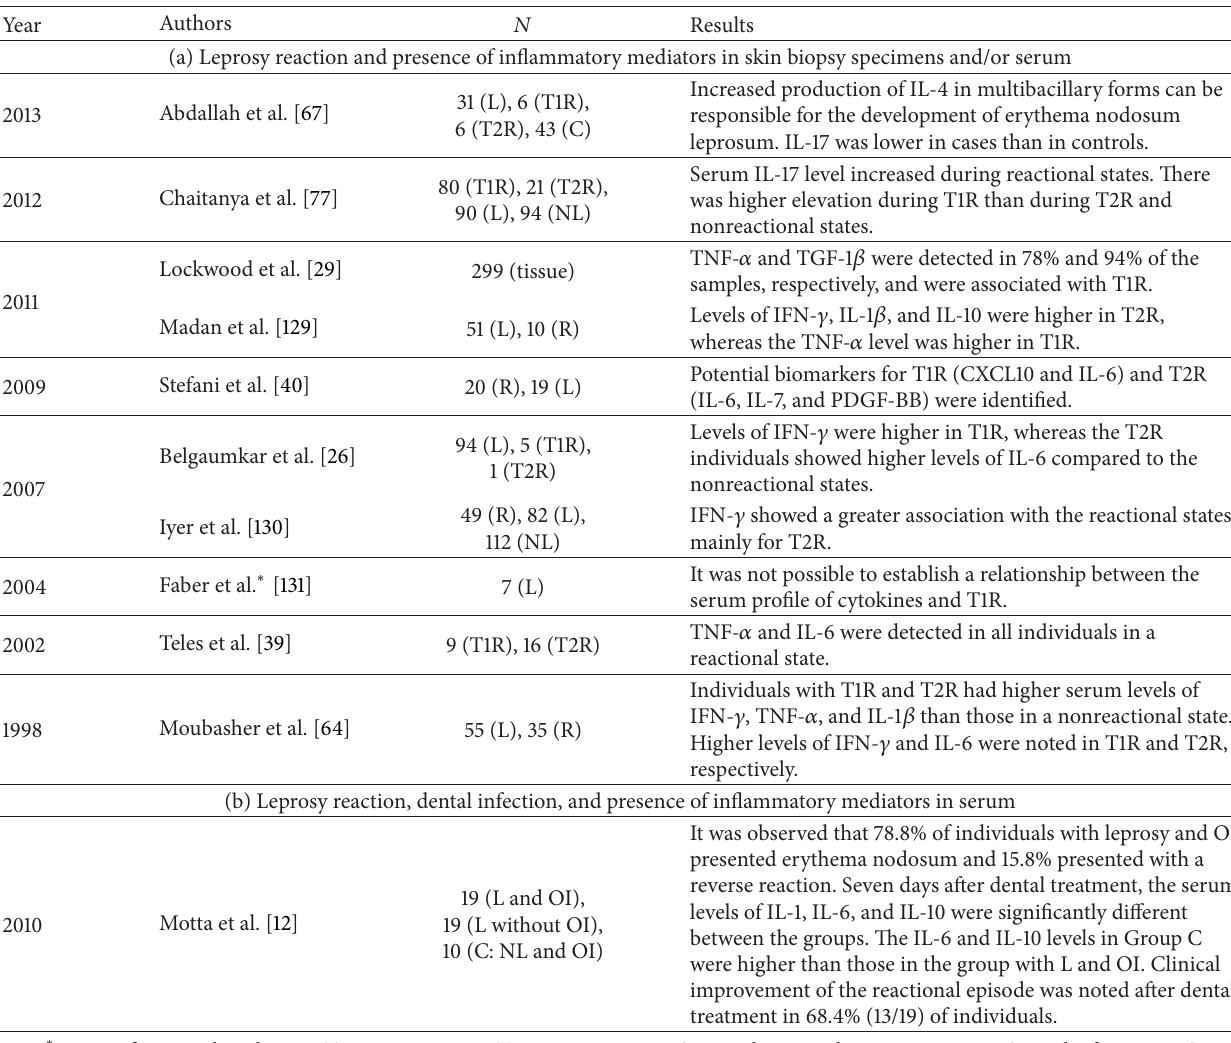
Table3:Articlesselectedforthesystematicreviewonleprosyreactionsandpresenceofmediatorsinskinbiopsyand/orserum(a)andleprosy reaction, dental infection, and presence of cytokines (b) according to the publication year, authors, type of sample, and obtained